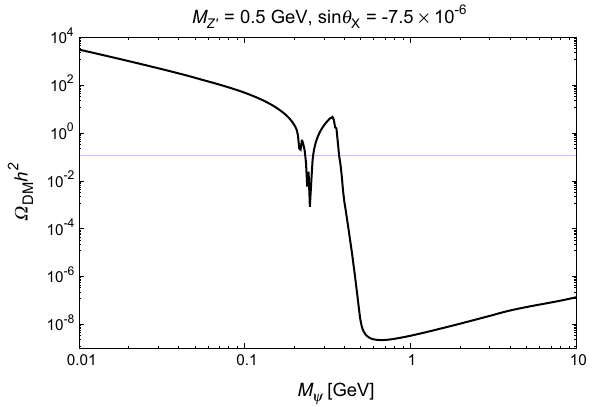
Fig. 2 The relic density with respect to the DM mass for the bench- marking point ( m Z (cid:2) , sin θ X ) = ( 0 . 5 GeV , − 7 . 5 × 10 − 6